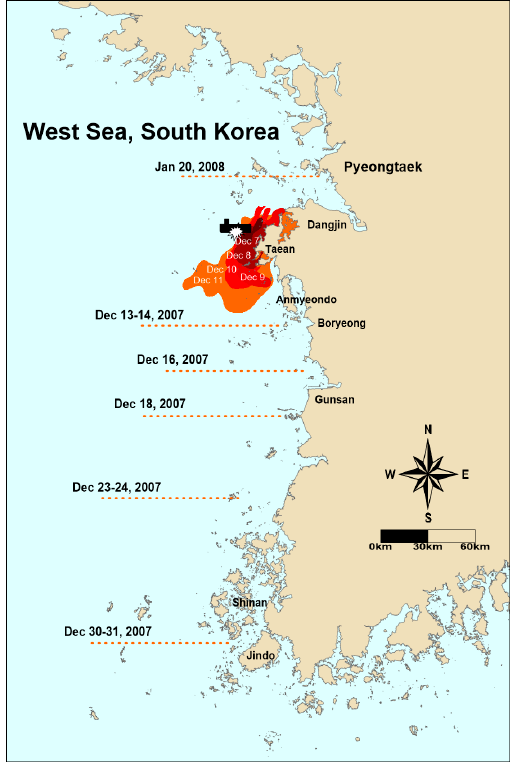
Figure 4. Spread of oil from Hebei Spirit in the west sea of Korea (reproduced from Kim et al. [11]).